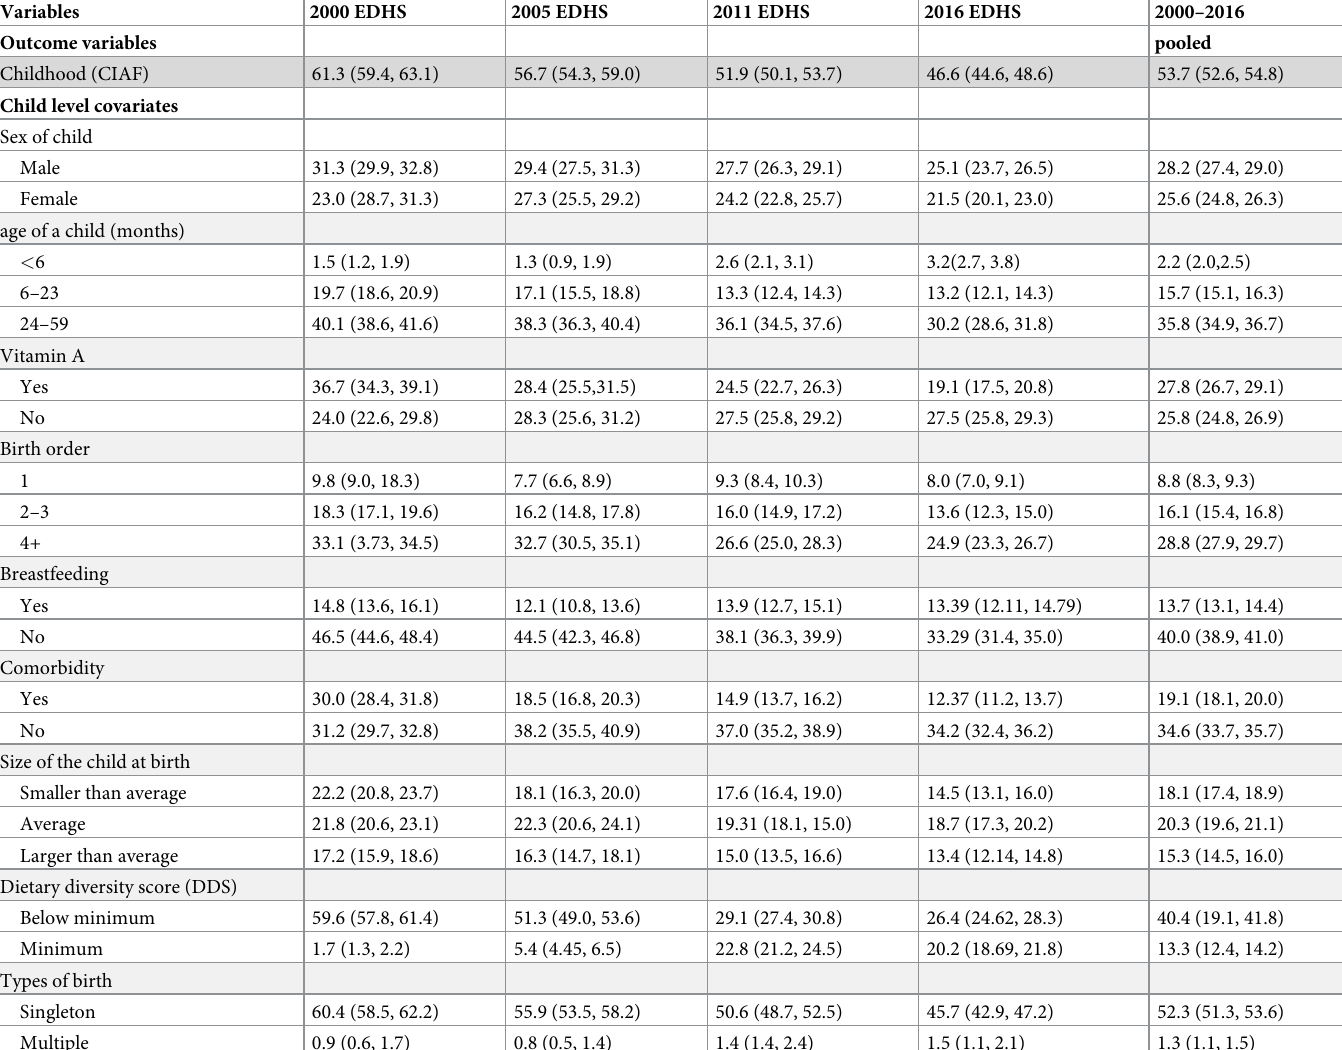
Table 2. The CIAF prevalence and their 95% CI for each of the child characteristics in Ethiopia,